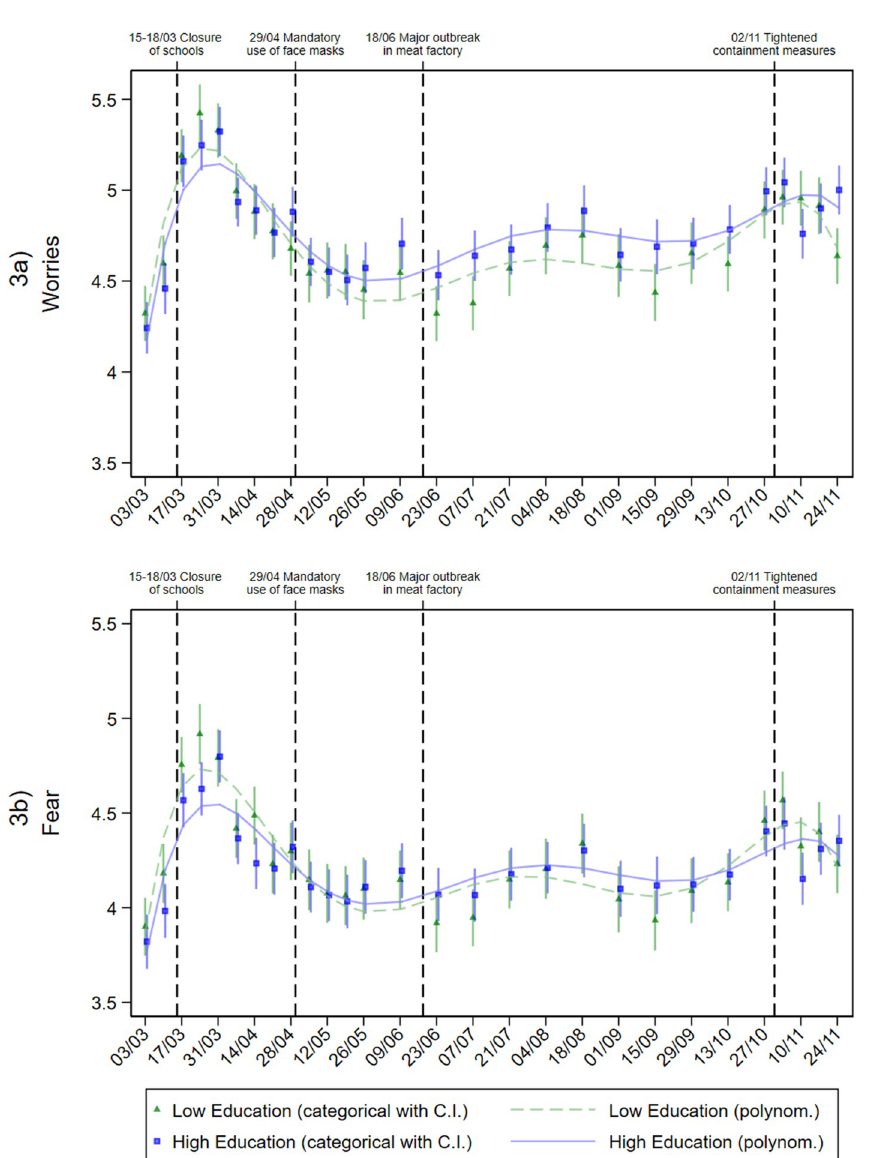
Fig 3. Affective dimensions of risk perception in individuals with different education levels during the pandemic. Adjusted predictions from linear regressions with interaction between education level and calendar week (categorial and metric), adjusted for age group, gender, repeat respondent, community size, and federal